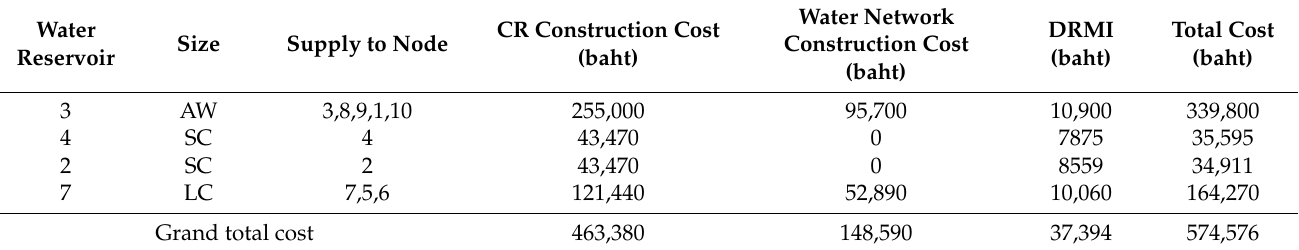
Table 3. Results of the assignment